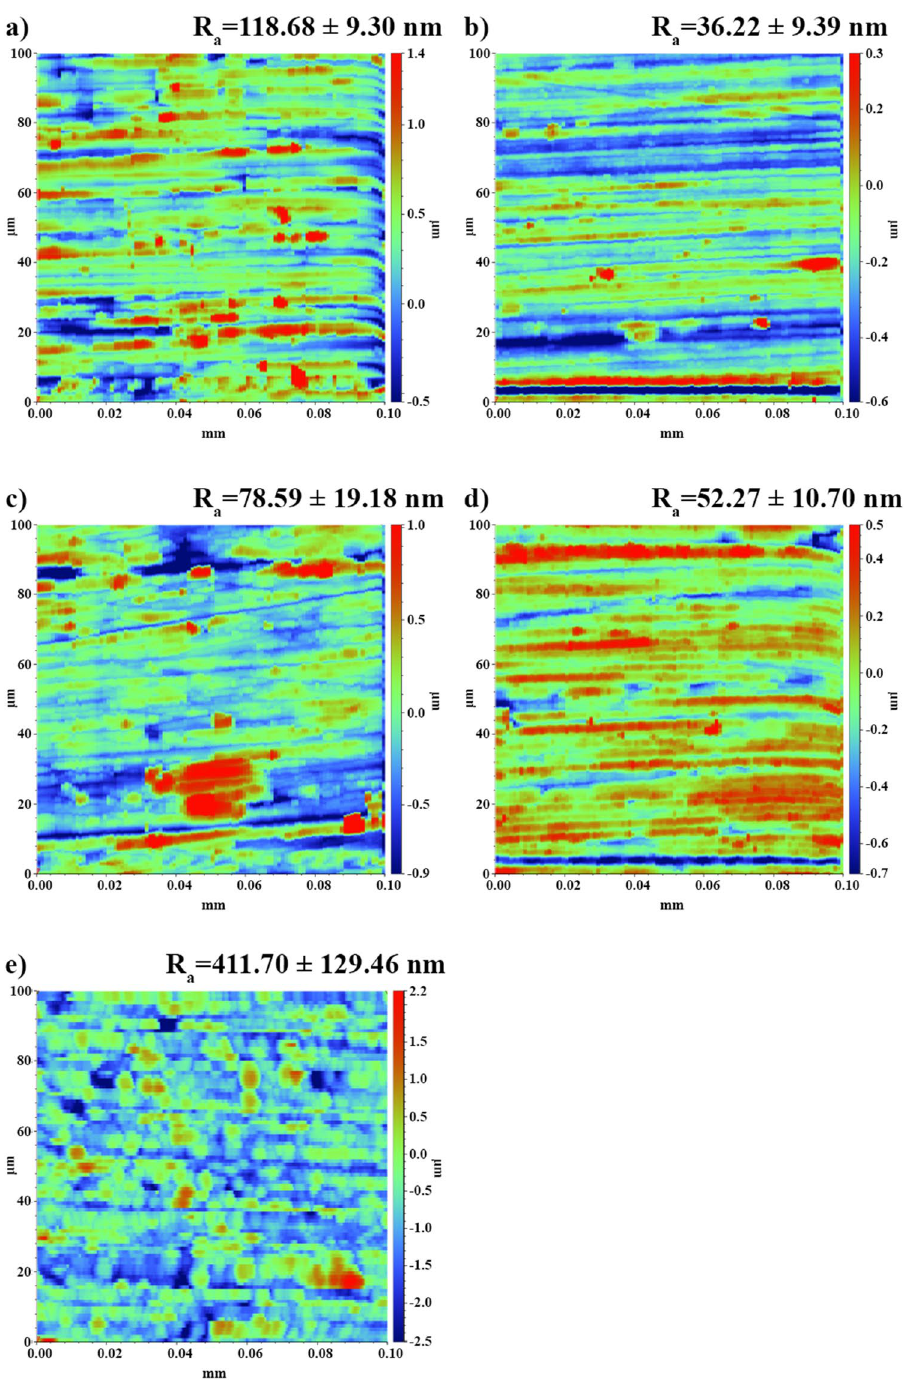
Figure 4. Topographic maps and the arithmetic average of the roughness profile (R a ) of the Ni–Mo alloy coatings deposited from DES + 0.2 mol dm −3 NiCl 2 + 0.01 mol dm −3 (NH 4 ) 6 Mo 7 O 24 at − 0.5 ( a ), − 0.6 ( b ), − 0.7 ( c ), − 0.8 ( d ) and − 0.9 V vs. Ag ( e ) for 60 min at 50